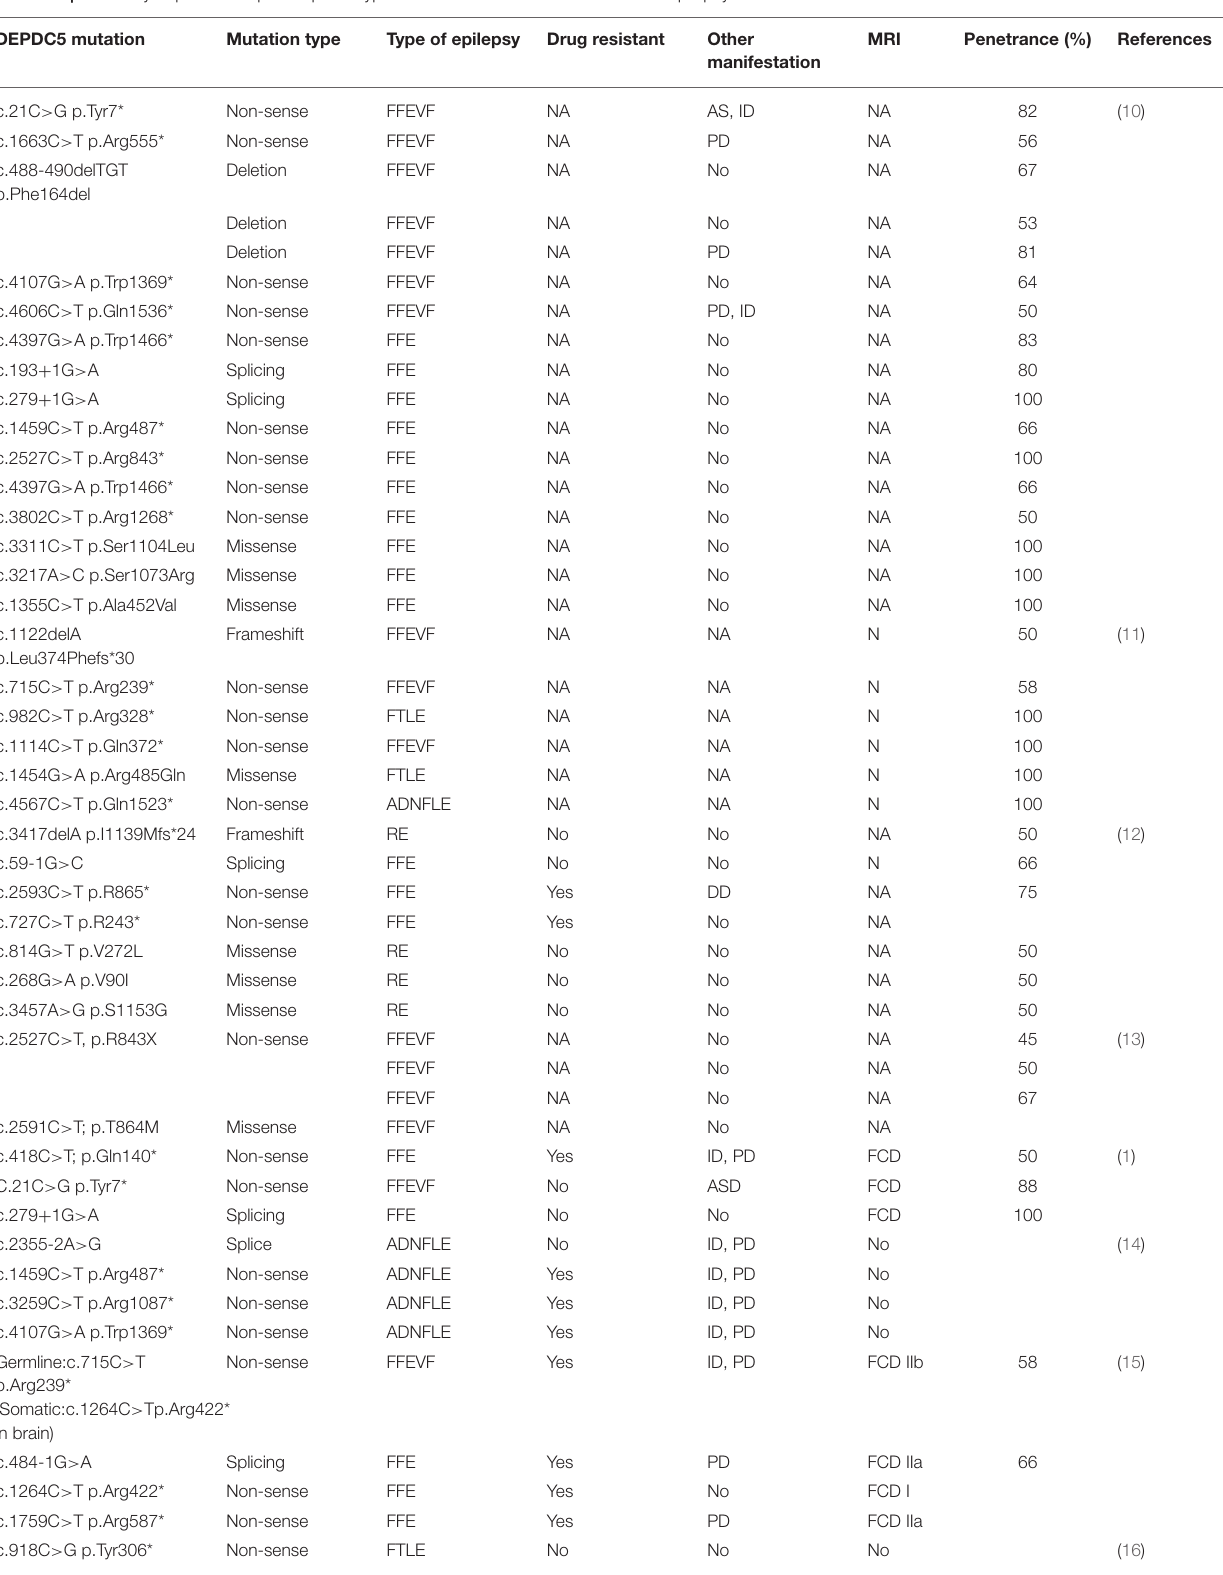
TABLE 2 | Summary of previous reported phenotype about DEPDC5-related familial focal